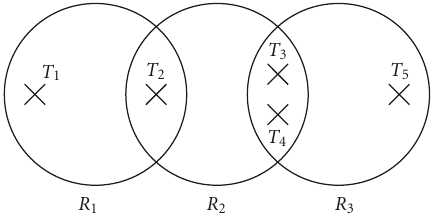
Figure 1: Example of wireless RFID network with redundant